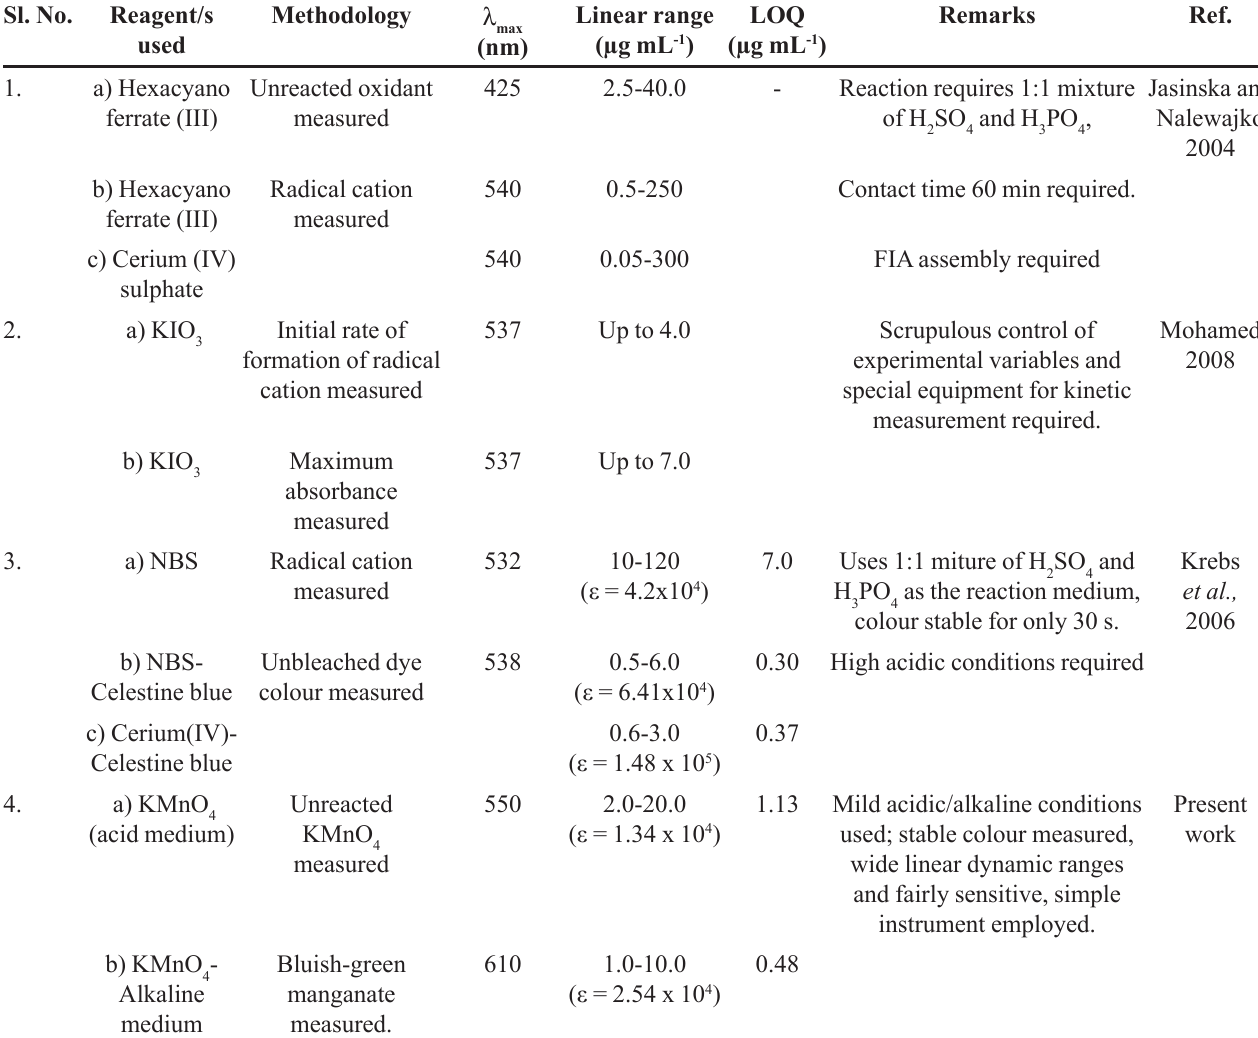
TABLE I - Comparison of the performance characteristics of the present methods with the published methods Sl.